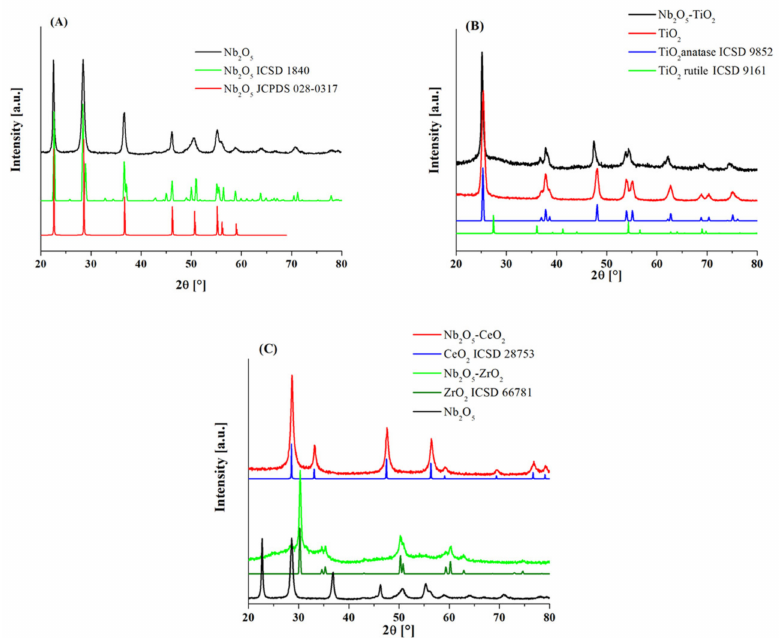
Figure 1. XRD patterns of ( A ) bare Nb 2 O 5 and ICSD/JCPDS reference files; ( B ) Nb 2 O 5 -TiO 2 , TiO 2 and anatase and rutile ICSD reference files; ( C ) Nb 2 O 5 -CeO 2 , Nb 2 O 5 -ZrO 2 and the corresponding ICSD reference